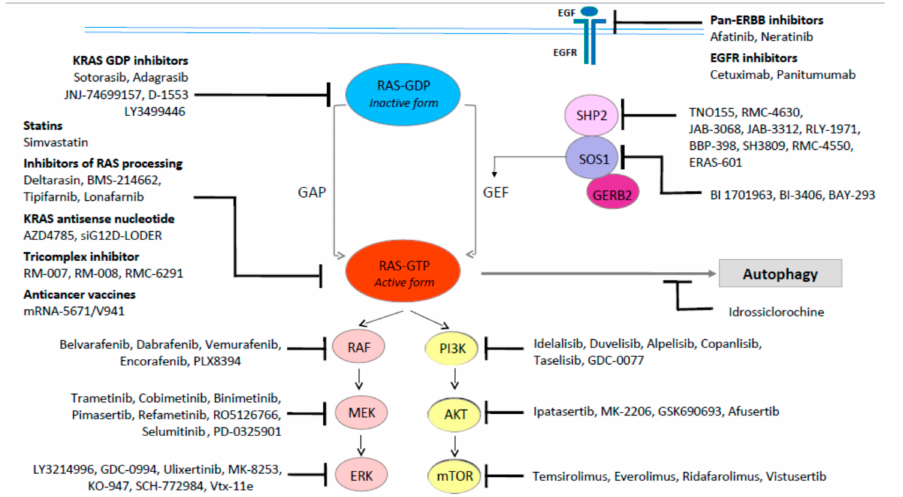
Figure 3. KRAS-targeting